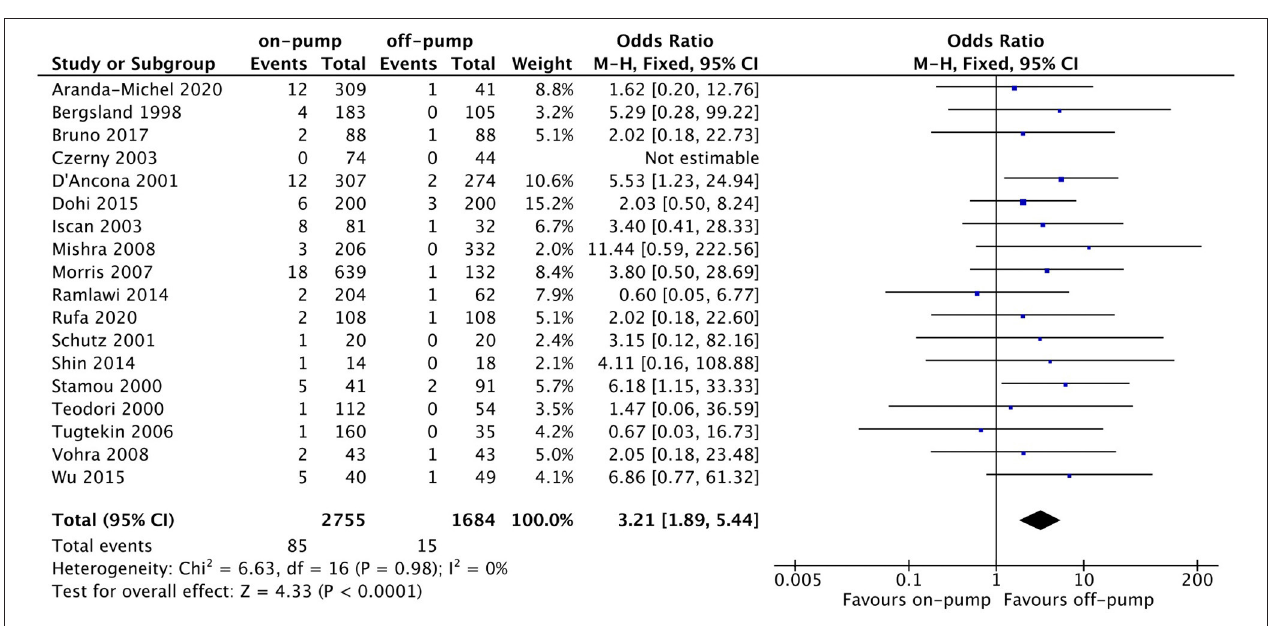
FIGURE 11 | Forest plot for perioperative neurological